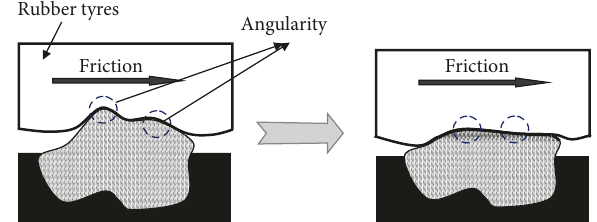
Figure 5: The change of macrotexture after the long-term polishing